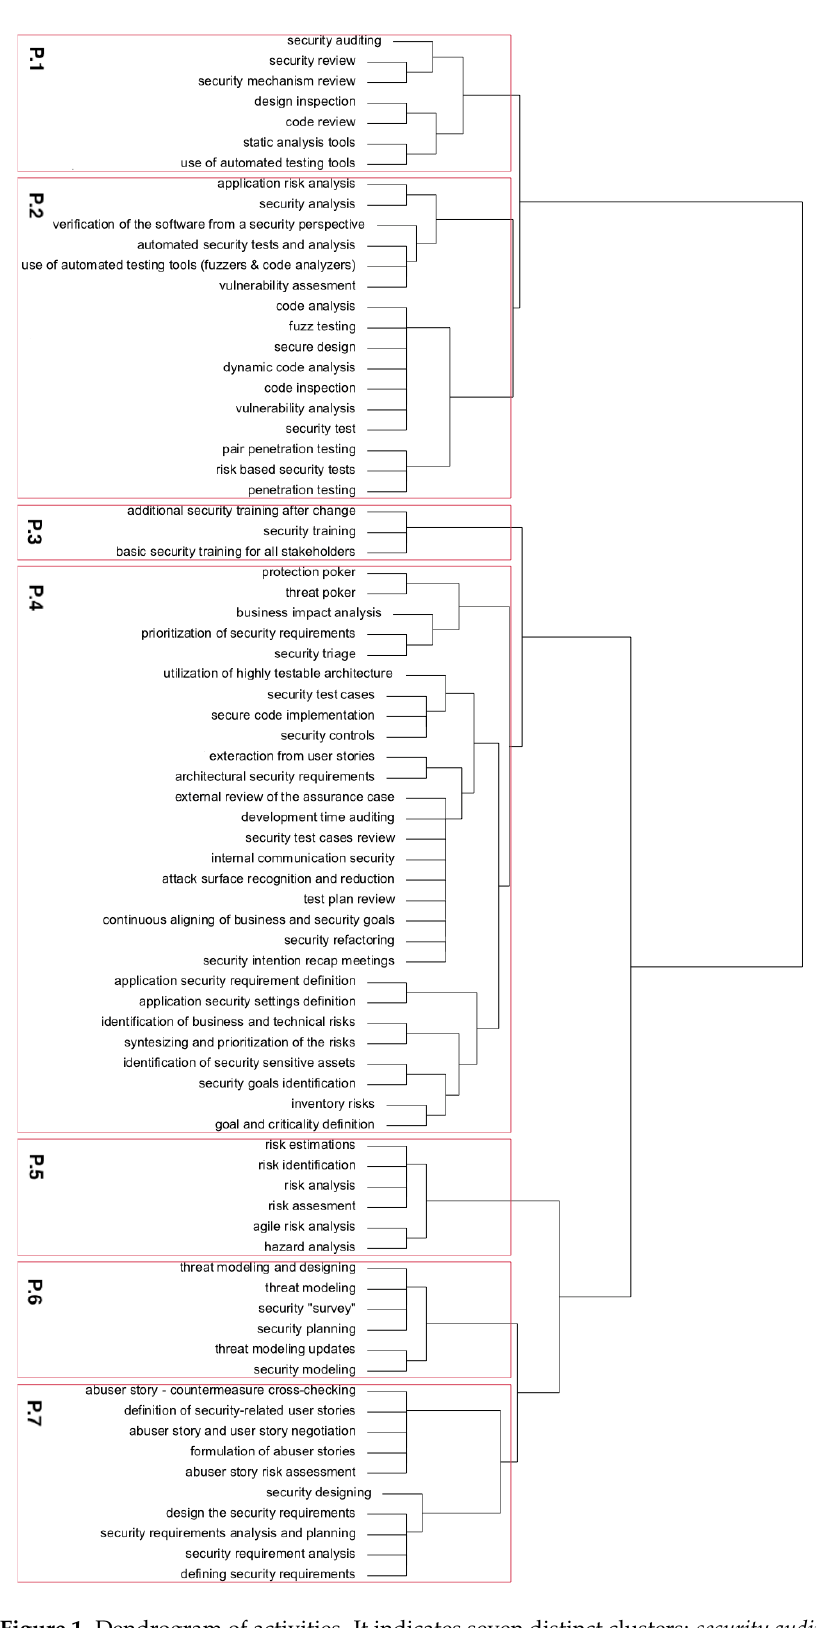
Figure 1. Dendrogram of activities. It indicates seven distinct clusters: security auditing (P.1), security analysis and testing (P.2), security training (P.3), security prioritization and monitoring (P.4), risk management (P.5), security planning and threat modeling (P.6), and security requirements engineering